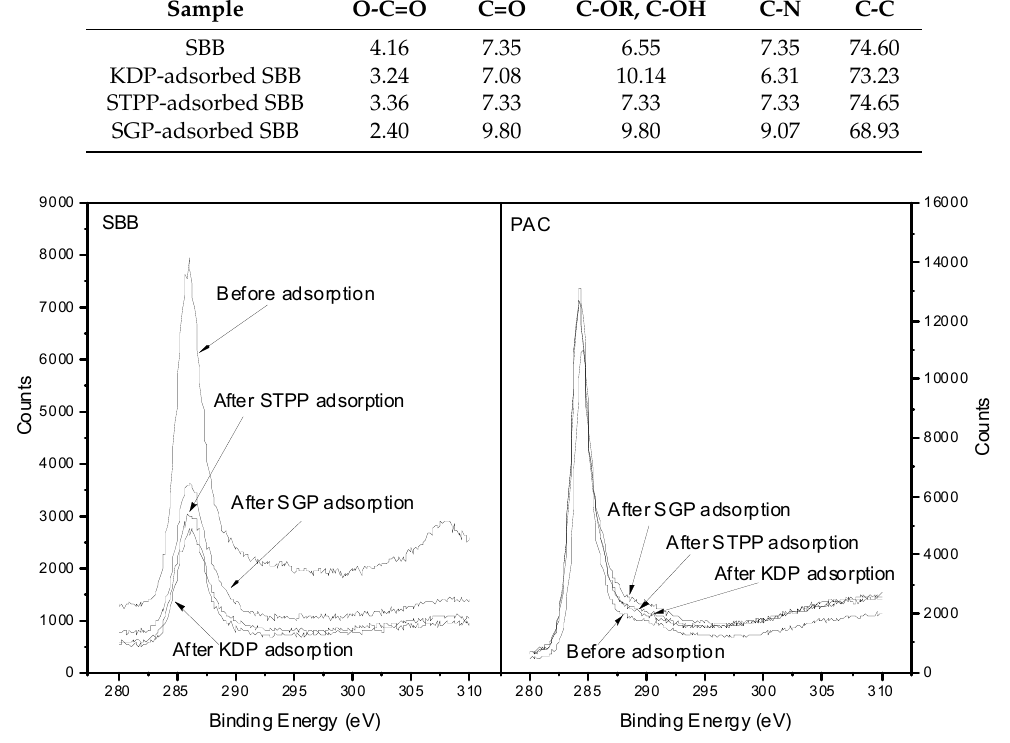
Figure 4. C1s XPS spectrums of SBB and PAC before and after phosphate adsorptions.